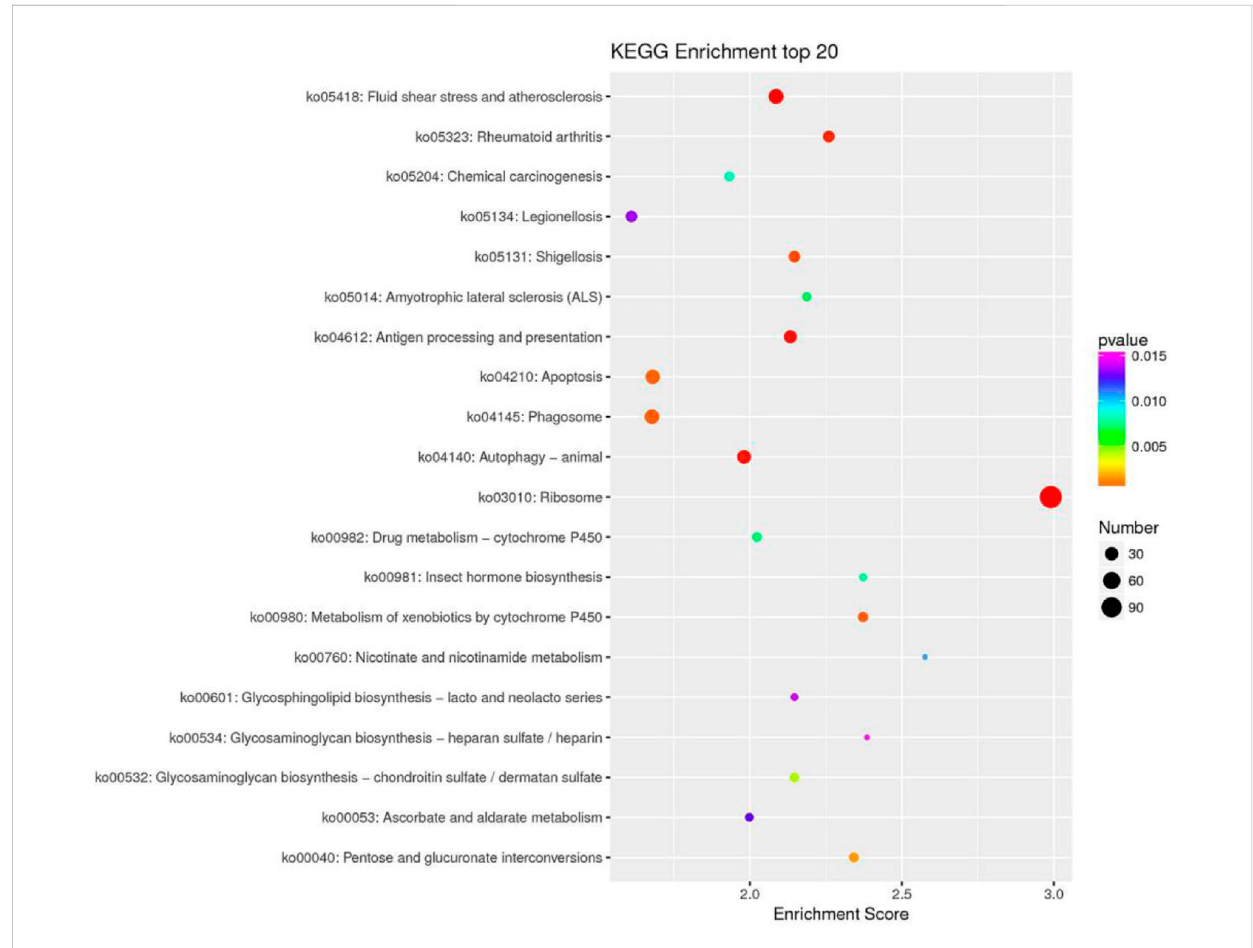
FIGURE 6 KEGG enrichment top 20 bubble plot (LC vs.